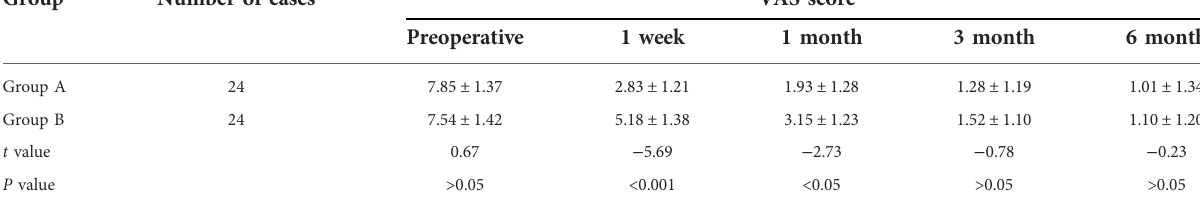
TABLE 2 Comparison of VAS scores at each follow-up point in the two groups.